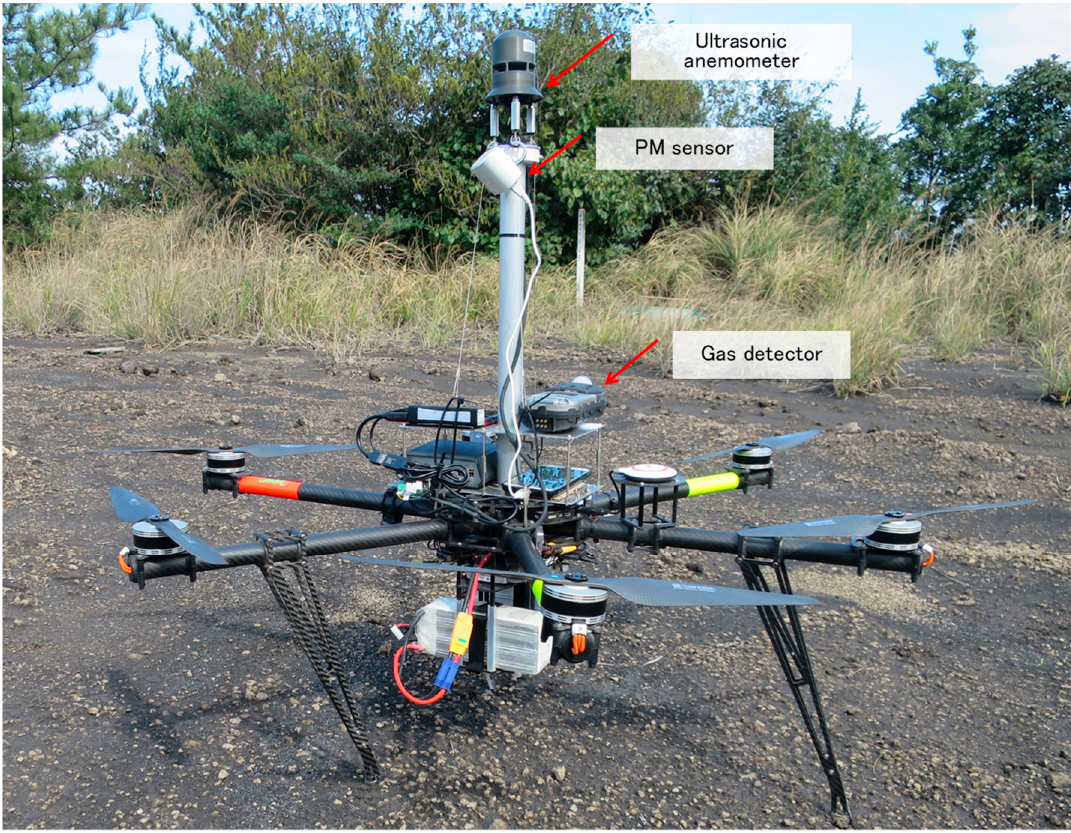
Figure 1. Drone equipped with ultrasonic anemometer, particulate matter (PM) sensor, and gas detector.